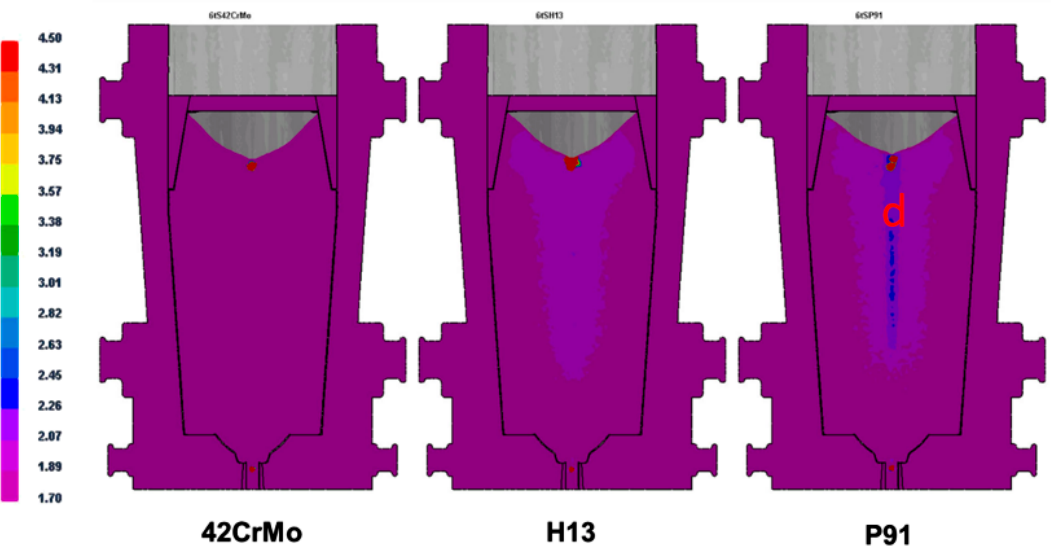
Figure 4. Simulated ferrite formation in stainless steel ingots with different mushy zone temperatures. “d” represents the shrinkage zone, i.e., ferrite formation band.